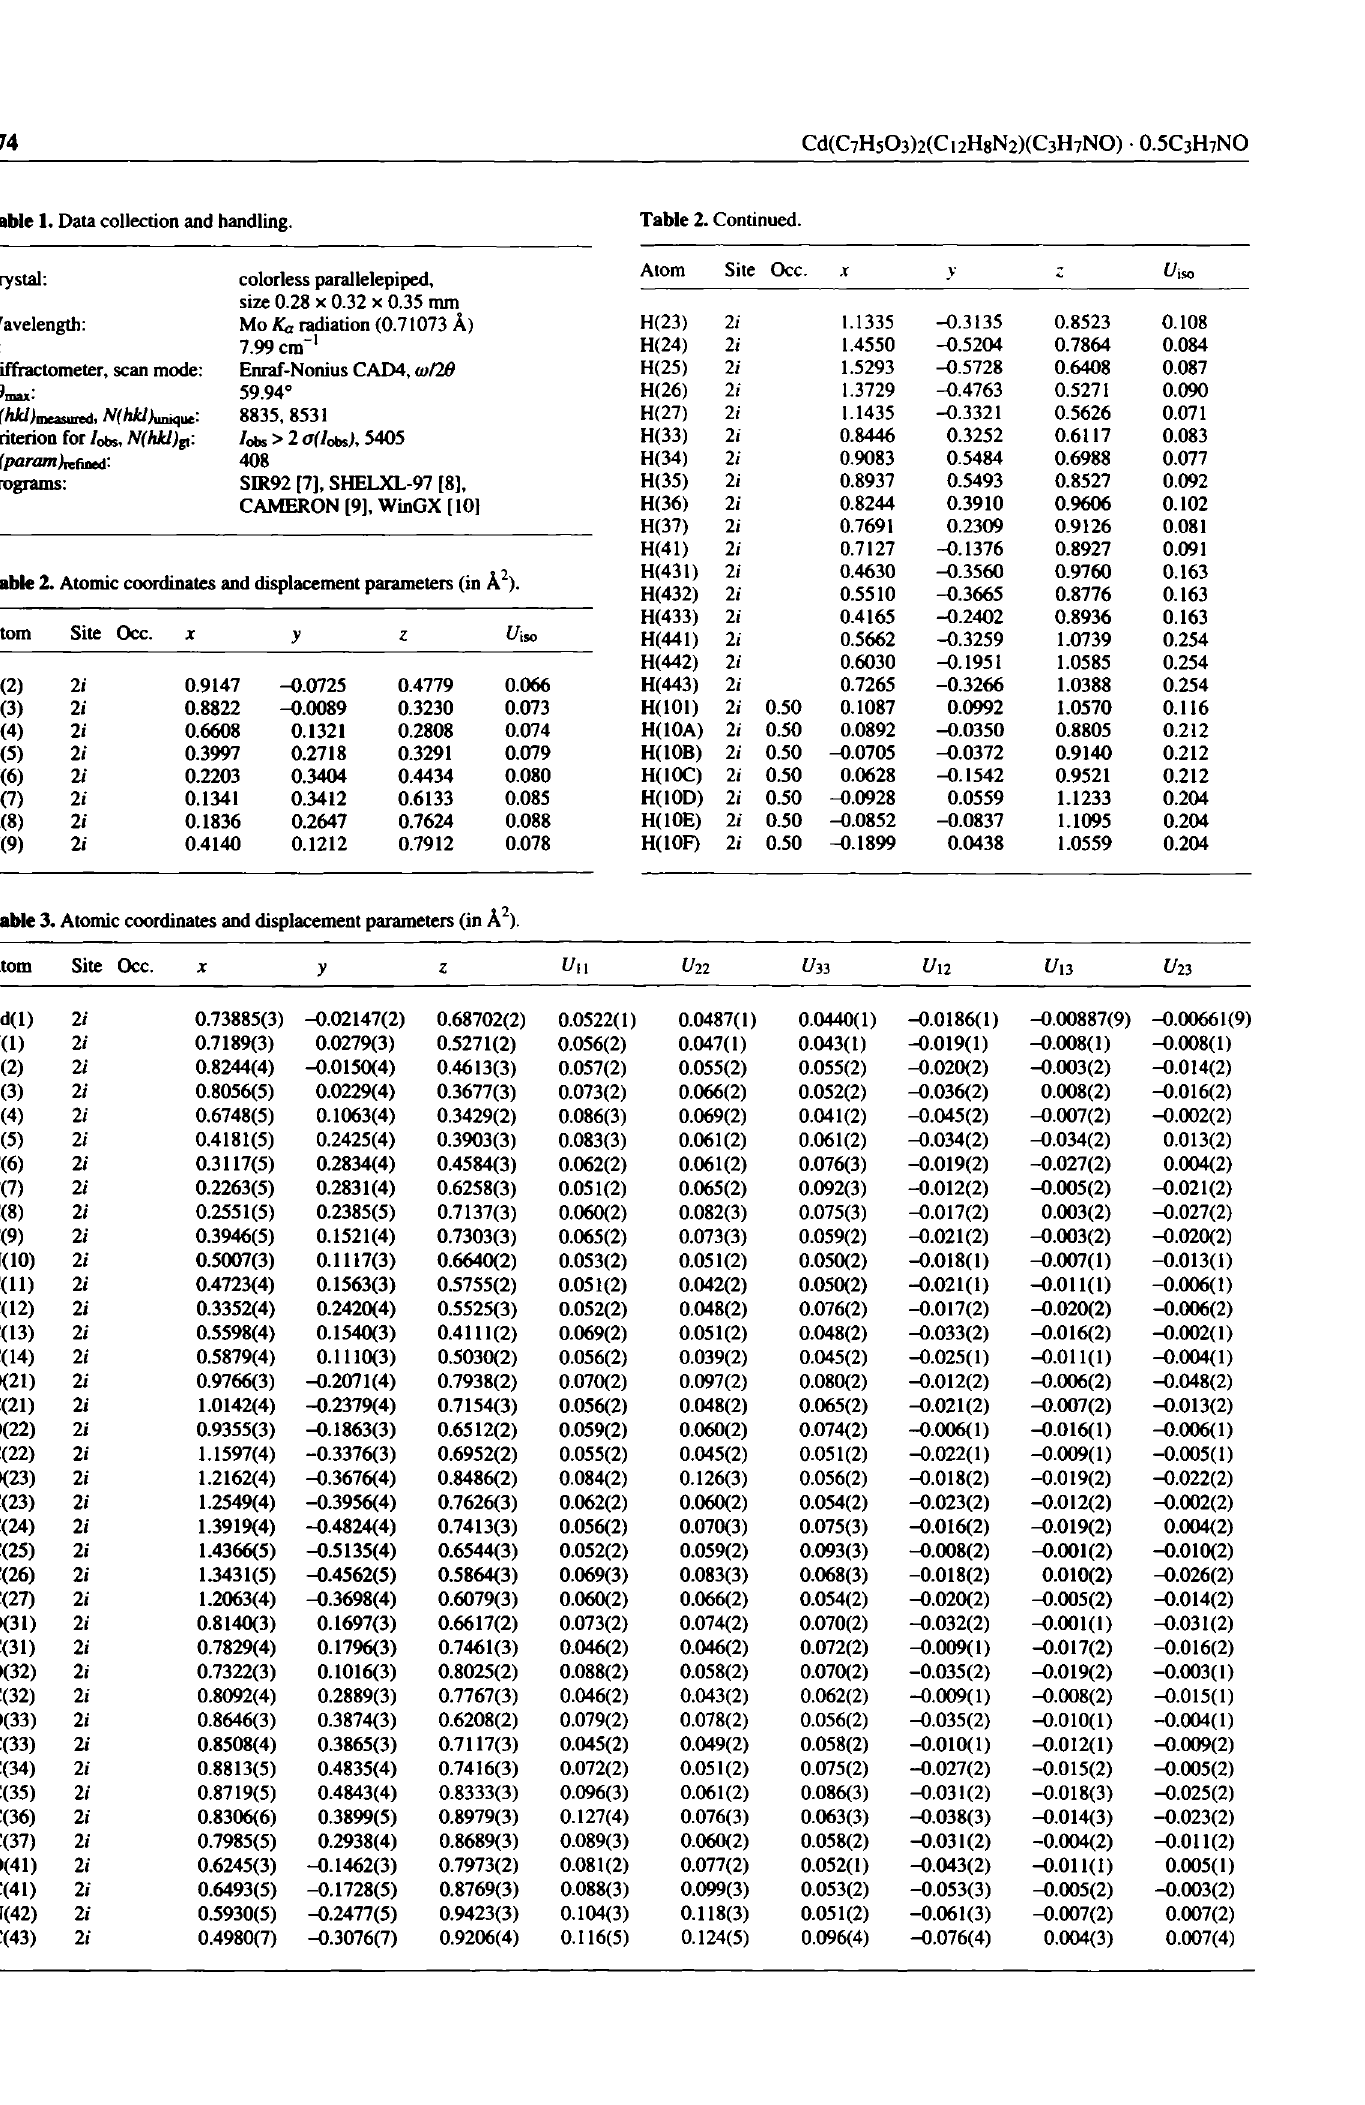
Table 3. Atomic coordinates and displacement parameters (in À 2